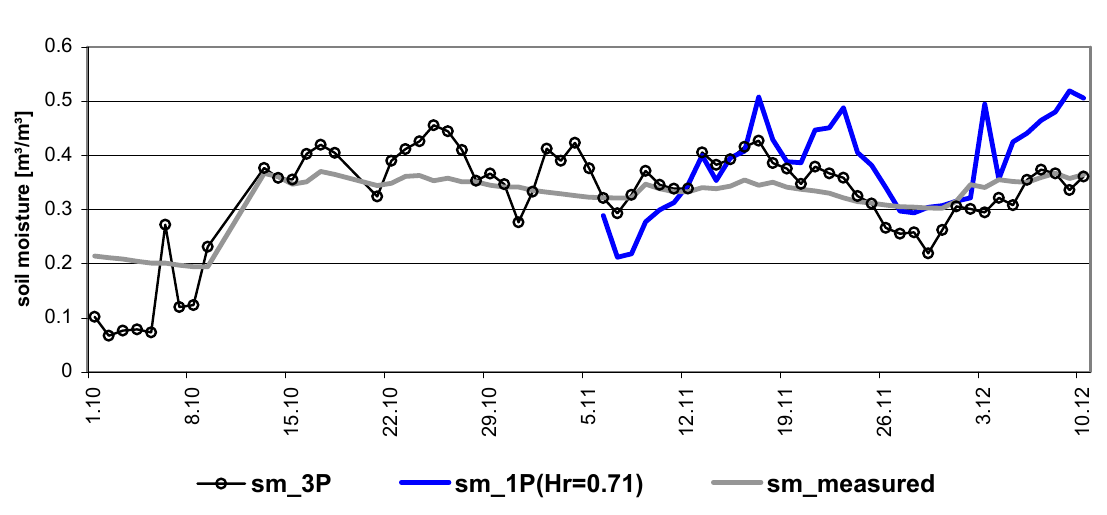
= 0.71 and the measured soil r